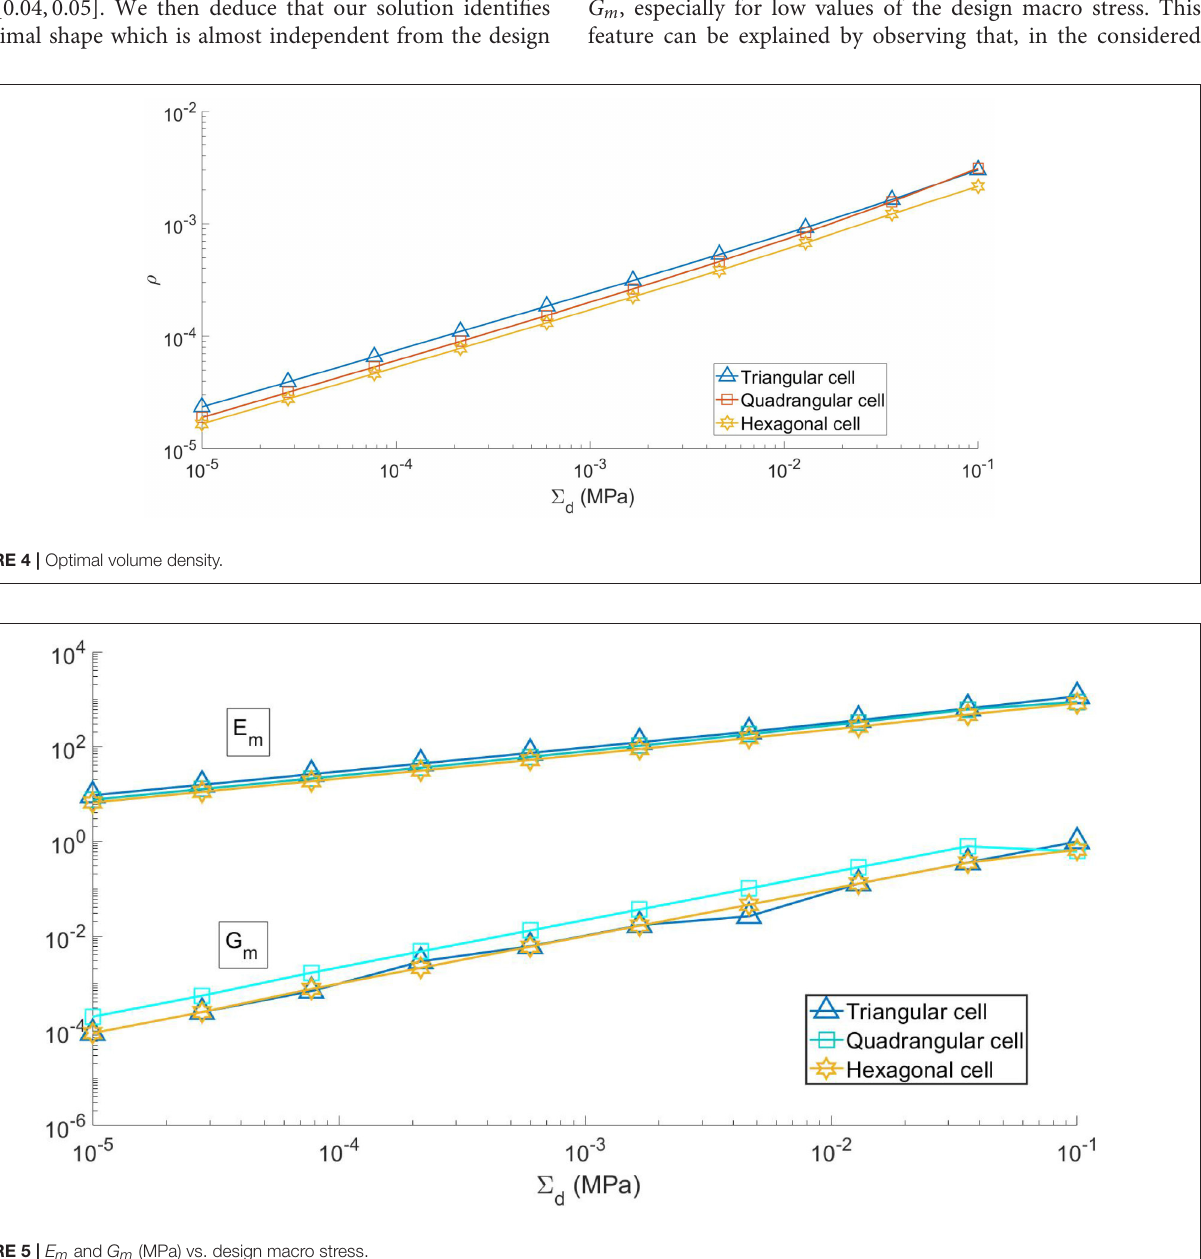
FIGURE 5 | E m and G m (MPa) vs. design macro